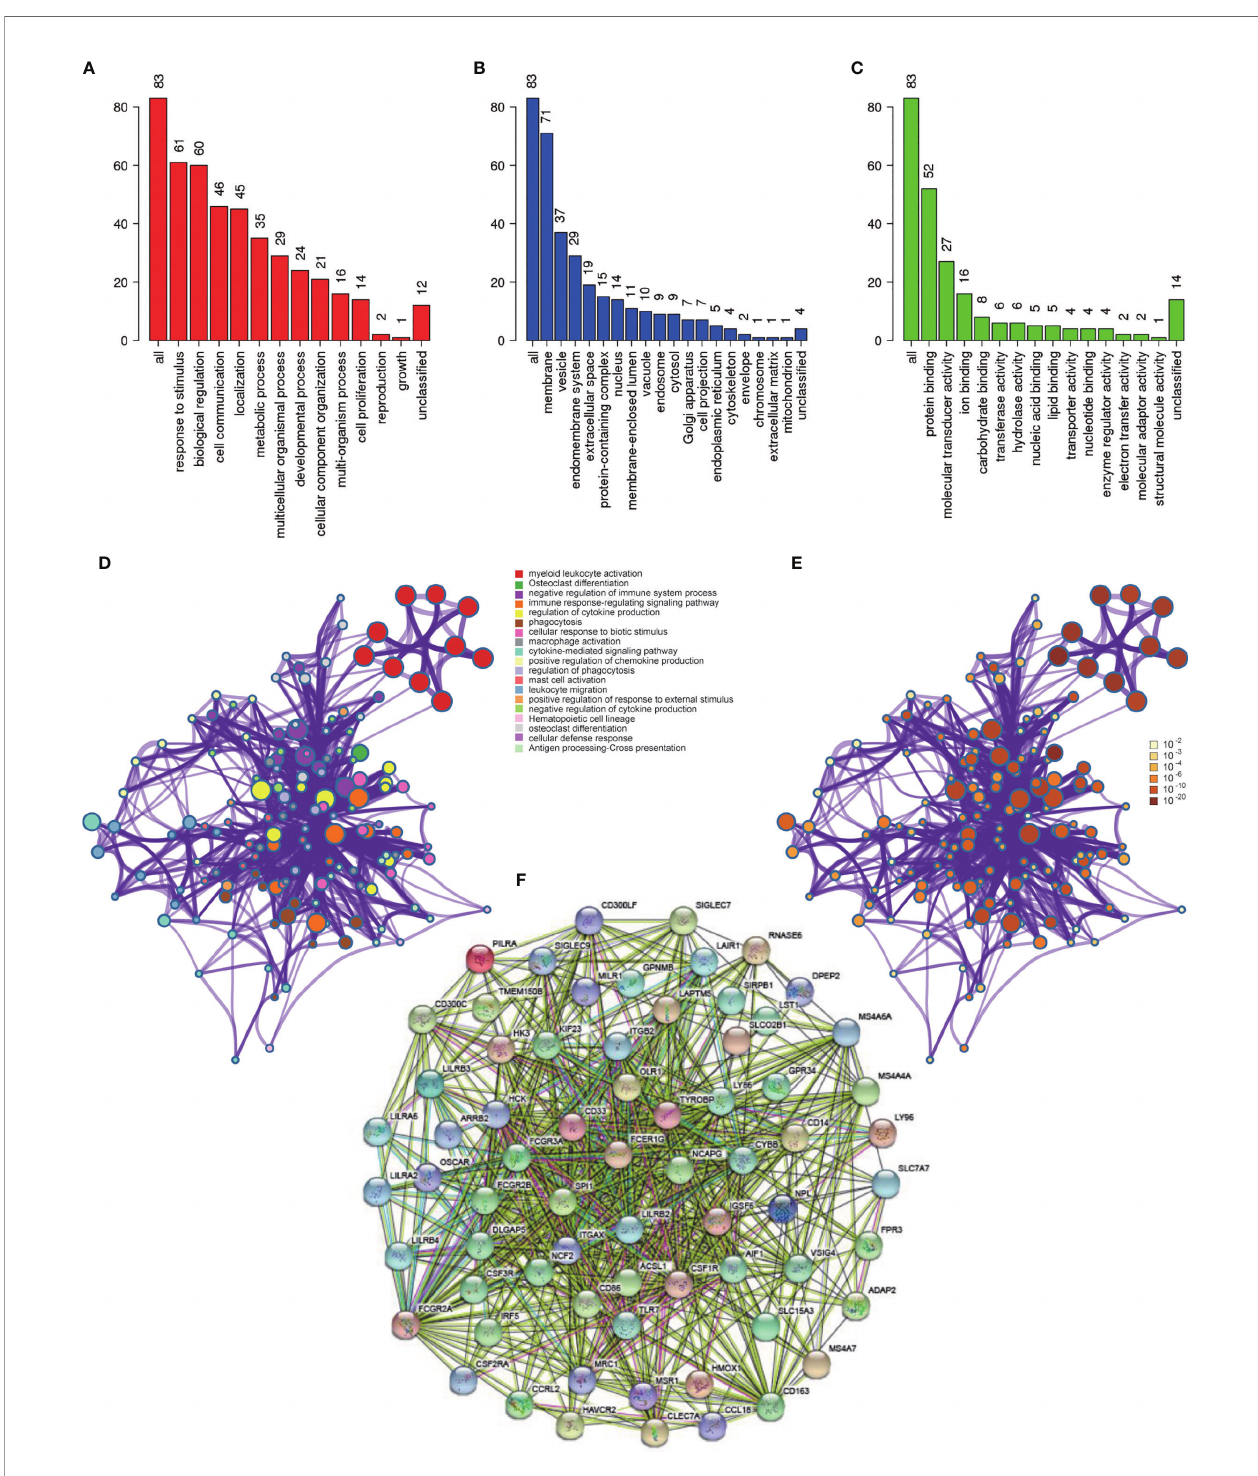
FIGURE 5 | Functional enrichment analysis and construction of PPI network. (A) GO analysis of biological process for genes in red module; (B) GO analysis of cellular component for genes in red module; (C) GO analysis of molecular function for genes in red module; (D) Functional enrichment analysis for genes in red module. (E) P -value of each gene in the network; (F) PPI network constructed using